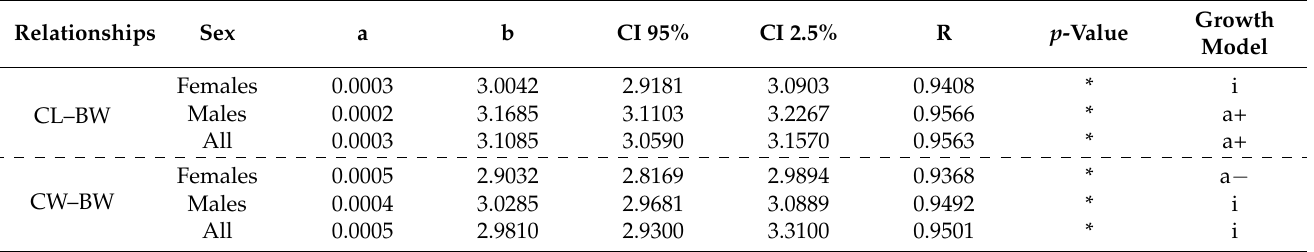
Table 3. Length–weight relationships and growth model for males, females, and the entire population of Percnon gibbesi captured in intertidal areas of Gran Canaria (* highly significant, p < 0.0001) (i = isometric, a+ positive allometry, a − = negative allometry).